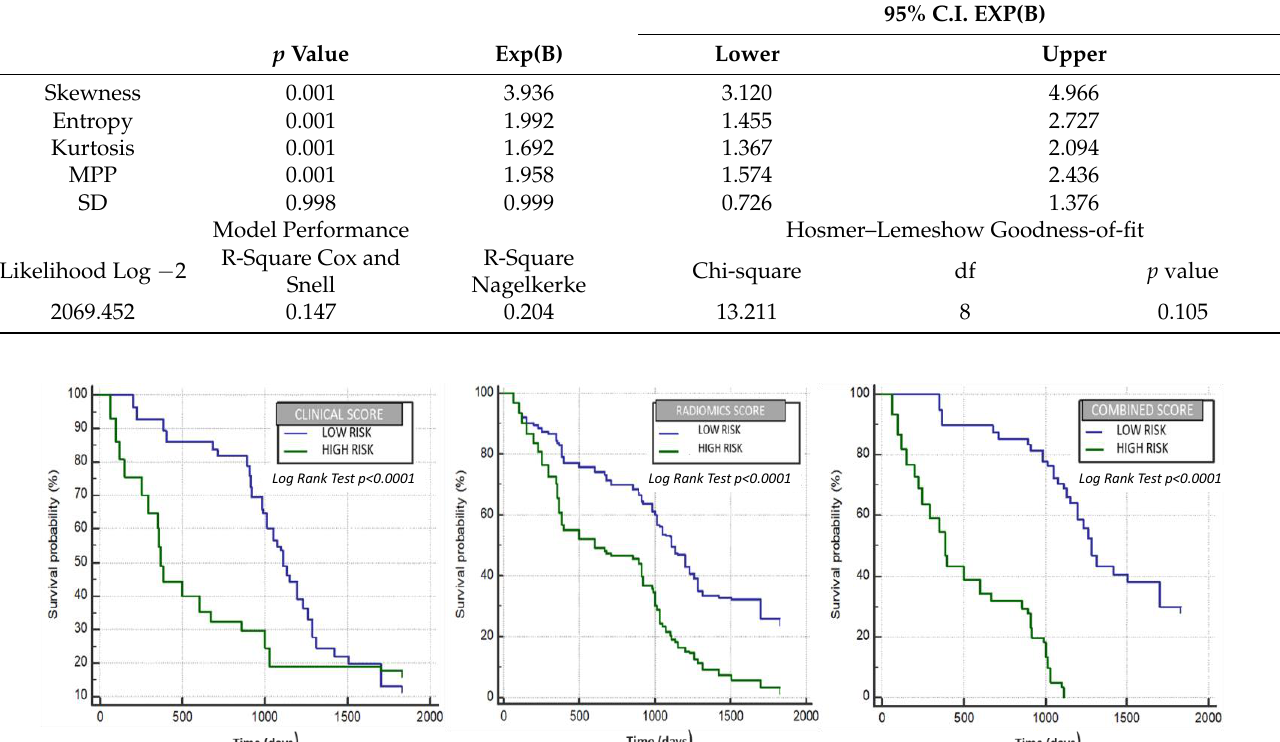
Table 4. Logistic Regression with Bootstrap Validation for Radiomics Features Association with Treatment Response.